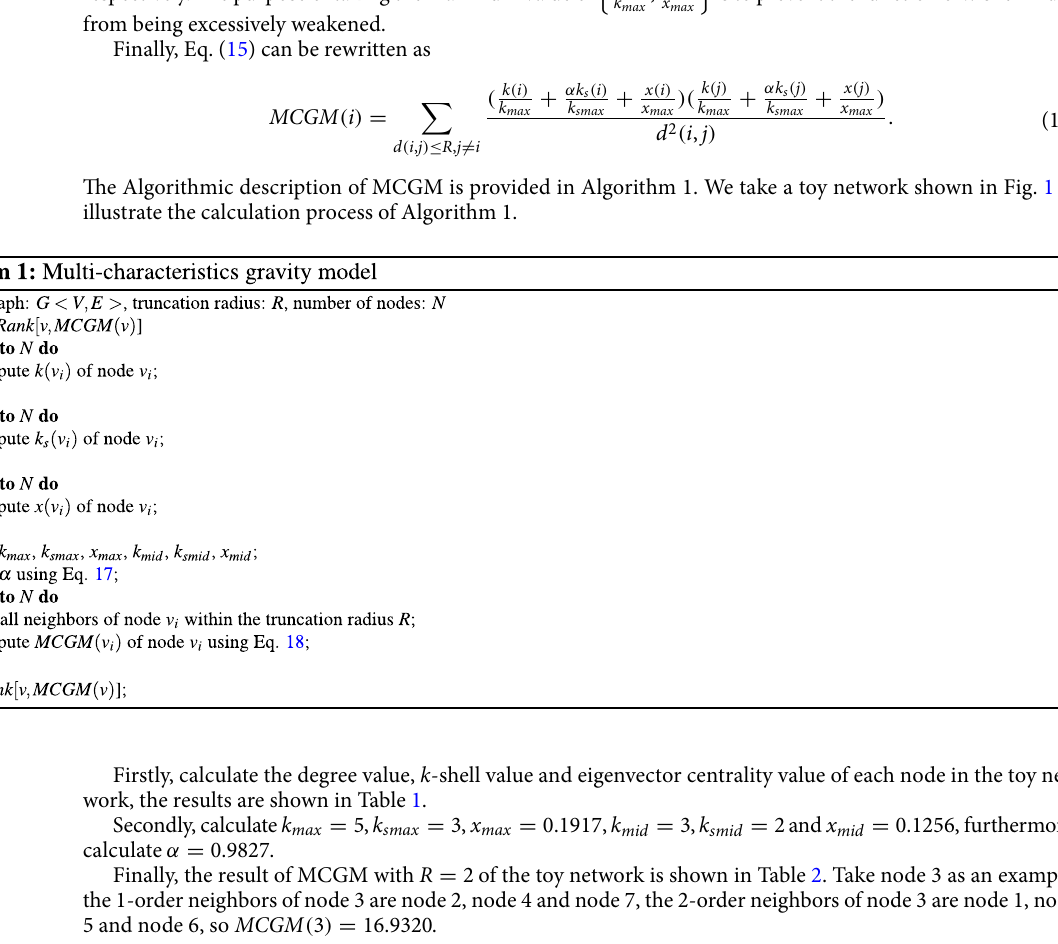
where k mid , k smid and x mid denote the median of degree value, k -shell value and eigenvector centrality value, respectively. The purpose of taking the maximum value of (cid:31) k mid k